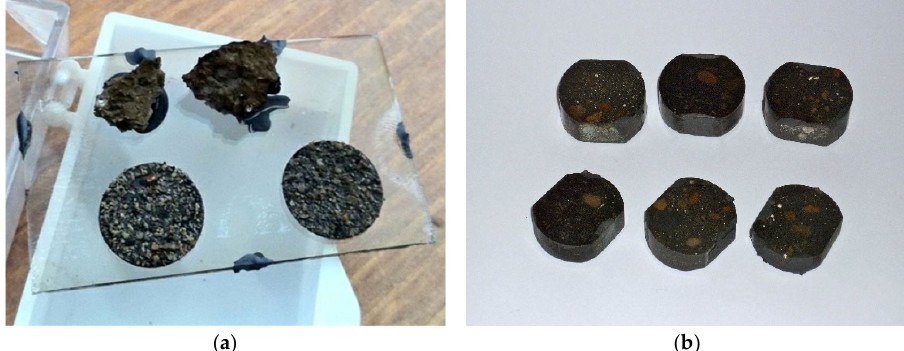
Figure 1. ( a ) Soil samples collected as “dust” specimens. ( b ) Soil samples extracted as “plug” specimens. The soil samples have been collected below each carcass, approximately between 100 and 125 cm depth.